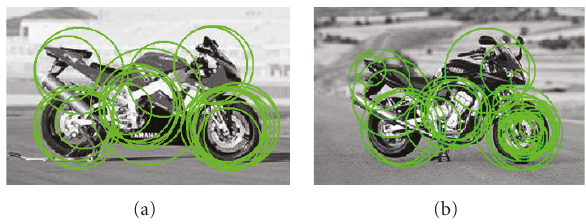
Figure 10: Detected CSR from Caltech motorbike